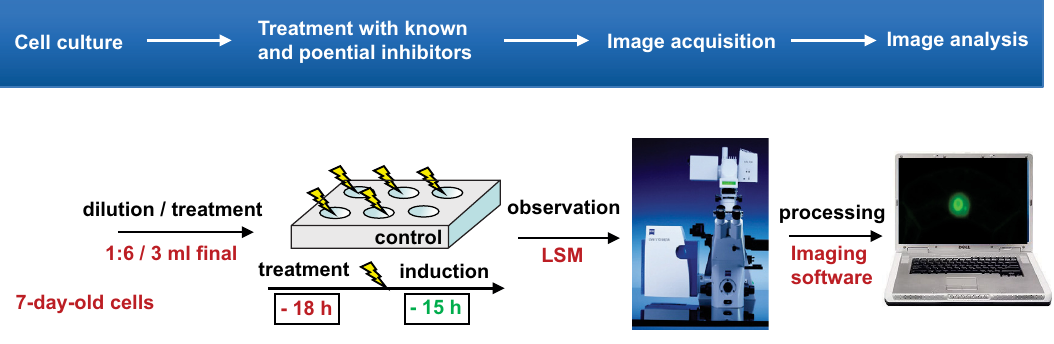
Figure S2. Setup for the bioassay developed during preceding studies 88 and used as basis for the experiments in the present work. The test system is based on a stably transformed tobacco BY-2 cell line expressing the chimeric, prenylable fusion protein H The expression is under the control of a dexamethasone-inducible promoter 116 . The usual timeline for an experiment consisted of 3 h treatment followed by an induction of protein expression varying between 15–48 h depending on the experimental setup. During that period the cells were grown under constant shaking in the dark at 27°C before the phenotype was analyzed using confocal laser